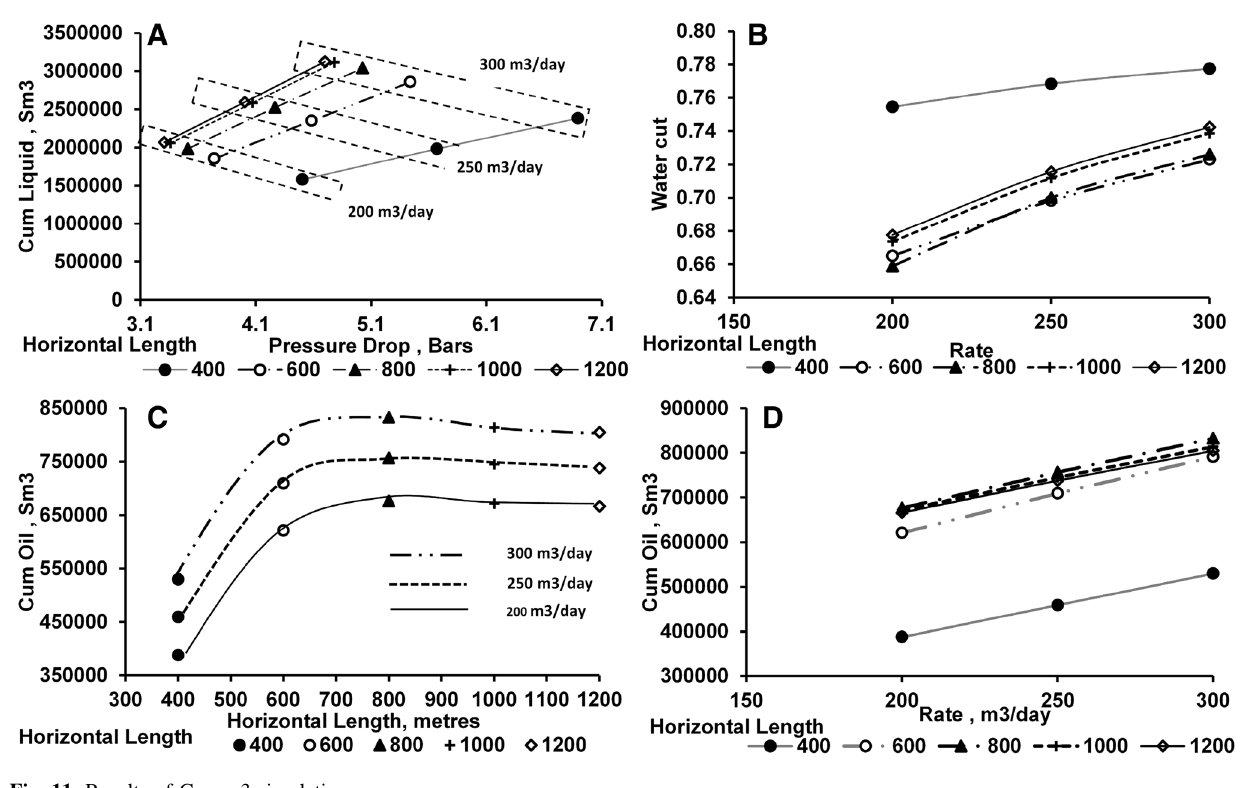
Fig. 11 Results of Group-3 simulation